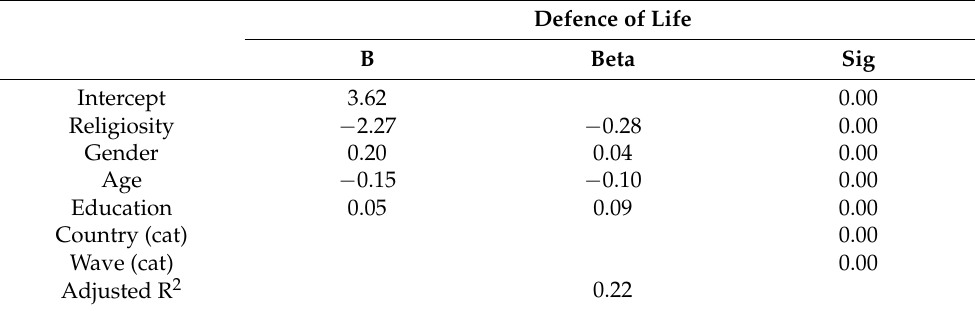
Table 3. OLS regression on Defence of life. A more detailed table is available in the Supplementary